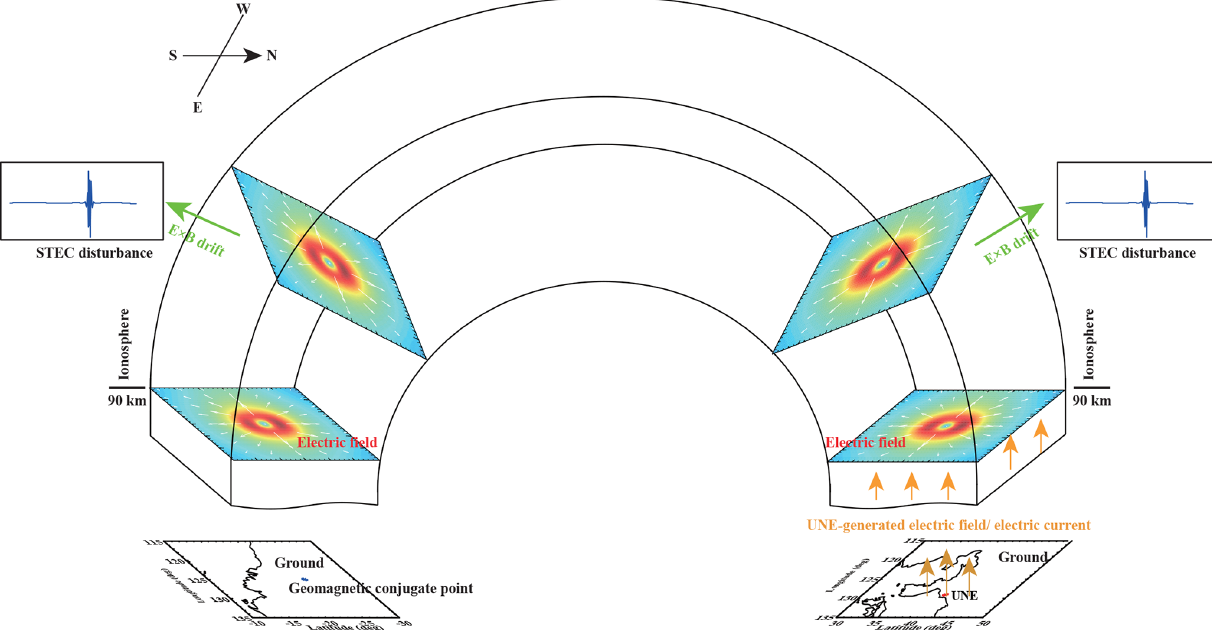
Figure 8. A sketch of the geomagnetic conjugate effect related to the UNE in the region of the nuclear test site nearby and the corresponding geomagnetic conjugate